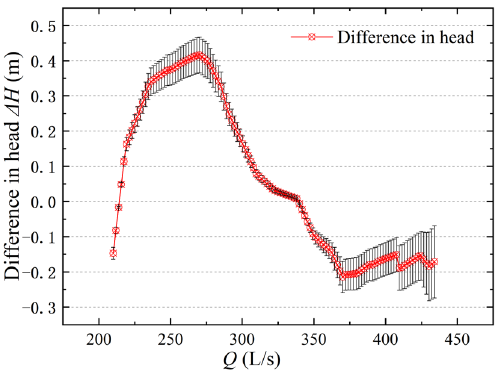
Figure 5. Head error analysis graph.